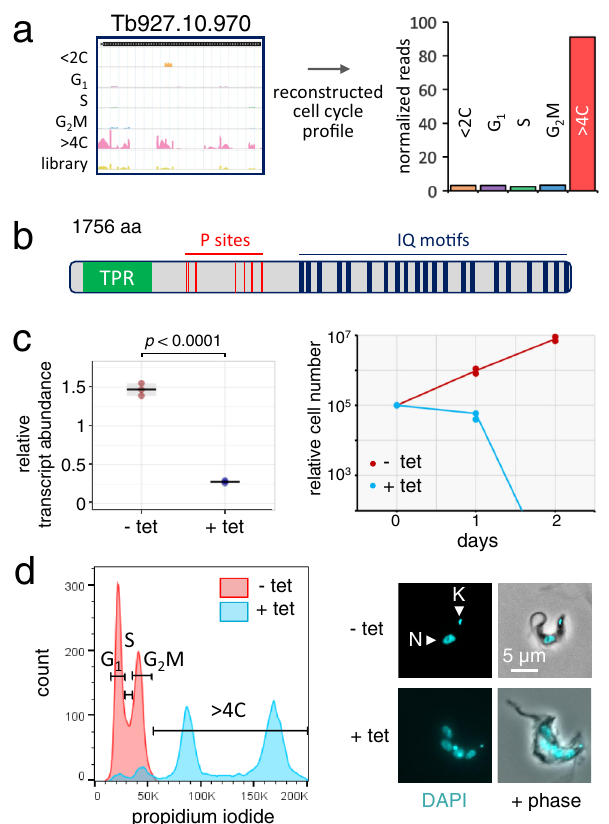
Fig. 7 | Validation of endoreduplication following Tb927.10.970 knockdown. a Mapped reads and reconstructed cell cycle pro fi le following 10.970 knockdown. b Schematicmapof10.970.TPRtetratricopeptiderepeatmotif,Pphosphorylation, IQ motifs, putative calmodulin-binding domains. c The plot on the left reveals ef fi cient tetracycline (tet)-induced knockdown of 10.970 after 24h. Mean values and3technicalreplicatesareindicated,withthe p -valuederivedusinganunpaired t -test. The growth curve on the right reveals a severe growth defect following knockdown. n =2 biologically independent clones and the line indicates mean values. Source data are provided as a Source Data fi le. d Flow cytometry analysis revealed endoreduplication following 24h of 10.970 knockdown, based on propi- dium iodide staining. The gates indicate the various cell cycle stages, based on uninduced (- tet) cells. The panel on the right shows representative cells with DNA stained with DAPI (4 ′ ,6-diamidino-2-phenylindole) before and after knockdown. N nucleus, K